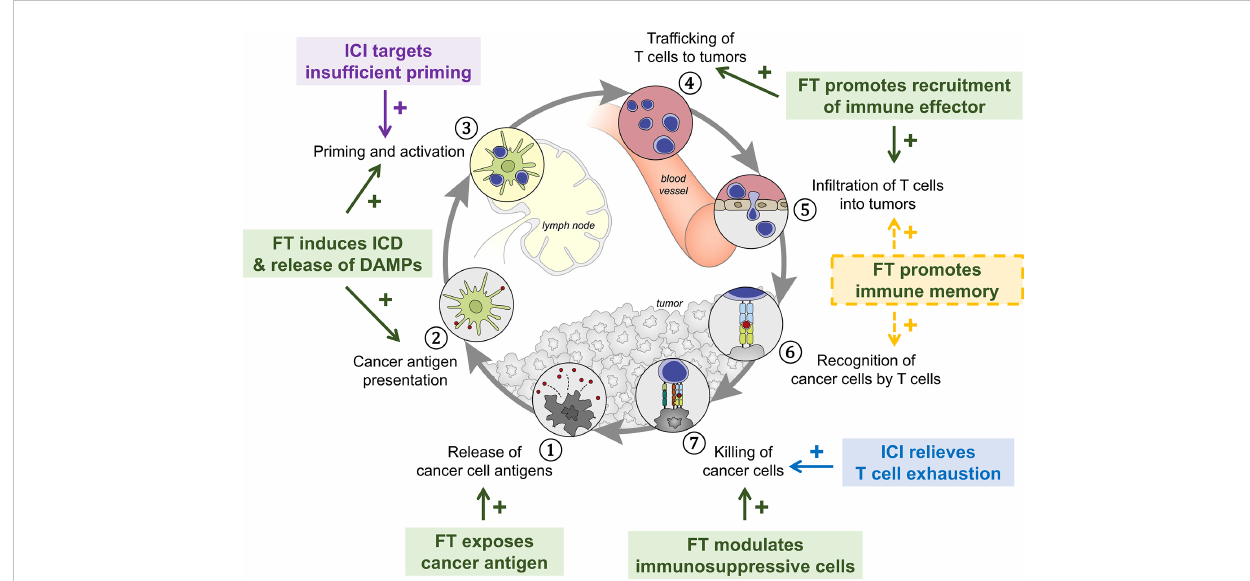
FIGURE 4 The intervention of focal therapy (FT) and immune checkpoint inhibitor (ICI) in the cancer-immunity cycle. The cycle has several major steps that have both immune-stimulatory and inhibitory factors. The immune response to the FT can be harnessed to amplify and broaden T cell responses while the ICI can target the immune regulatory feedback mechanisms that halt the development or limit the immunity. Working together, FT and ICI can facilitate the maintenance of central, effector and tissue-resident memory CD8 T cells to promote long-term immunosurveillance and